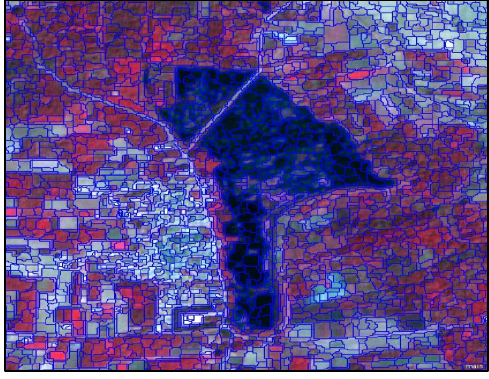
Figure 5: Segmentation (Level 15)